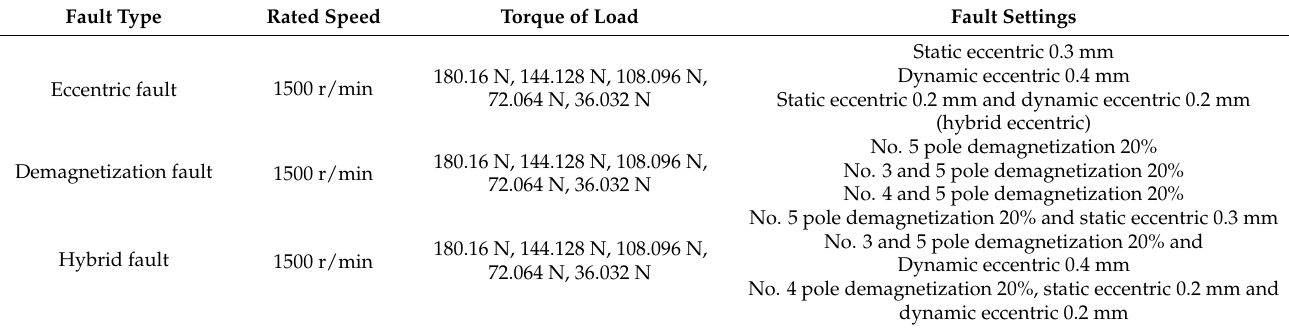
Table 2. The specific working conditions of the motor settings under various faults.